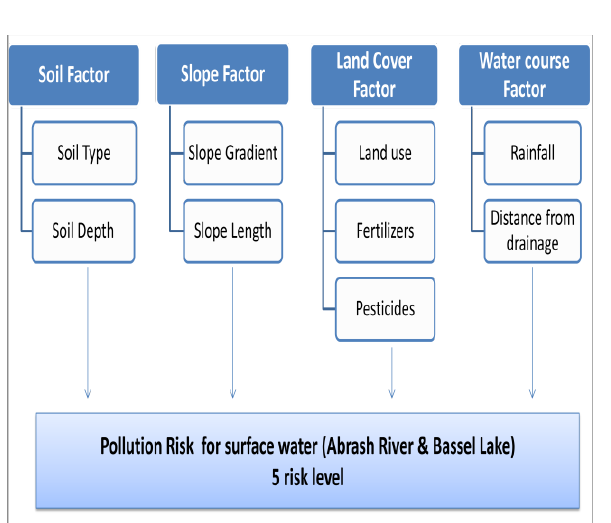
Figure (2): Flow chart of the pollution risk modeling